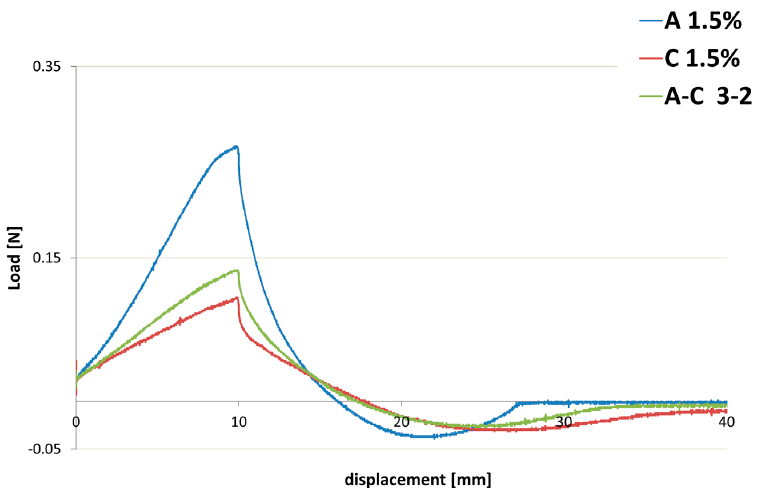
Figure 13. Texture curves obtained by an immersion/de-immersion test performed on the samples prepared with increasing polysaccharide total amounts (0.75%, 1%, and 1.5% w/w ) at different G–C ratios: 1:2 ( a ) and 1:3 ( b ).